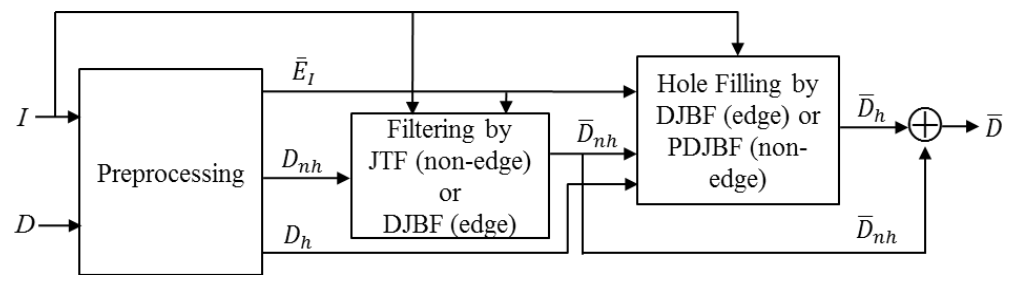
Figure 2. Block diagram for the proposed depth image filtering.